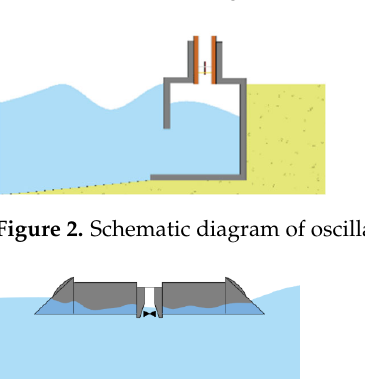
Figure 1. Schematic diagram of oscillating body type WEC.